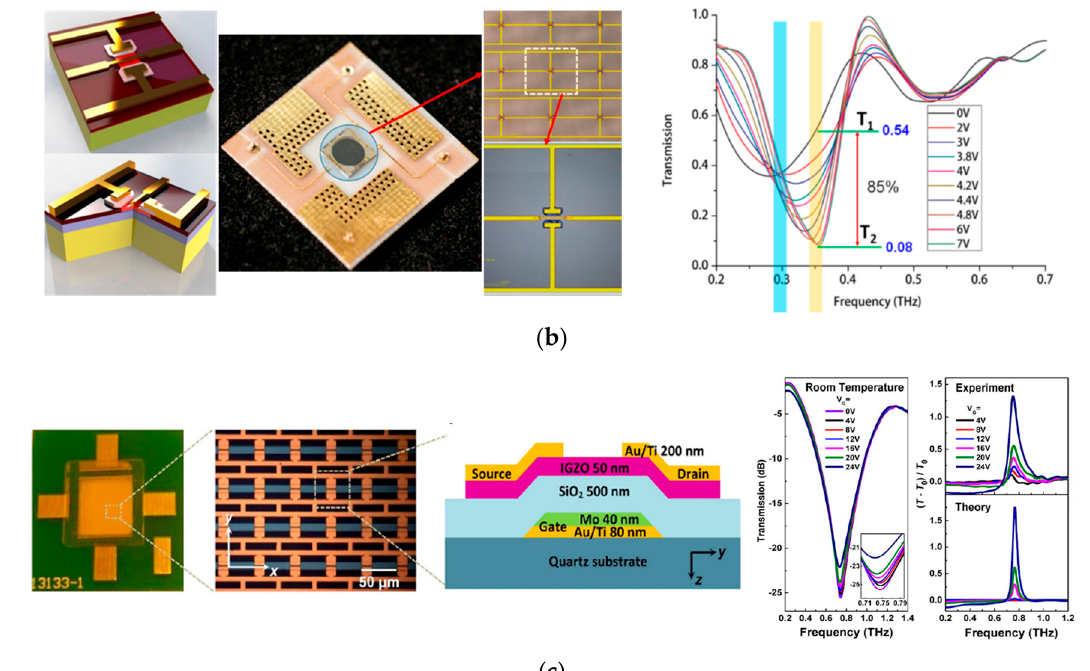
Figure 5. Active metasurfaces with FETs. ( a ) Configuration of a HEMT and its equivalent circuit model. ( b ) Terahertz metasurfaces modulated with HEMTs on GaN substrate [89]. Its modulation speed is up to 1 GHz. Copyright American Chemical Society, 2015. ( c ) IGZO TFT − based metasurfaces at 0.75 THz [93].